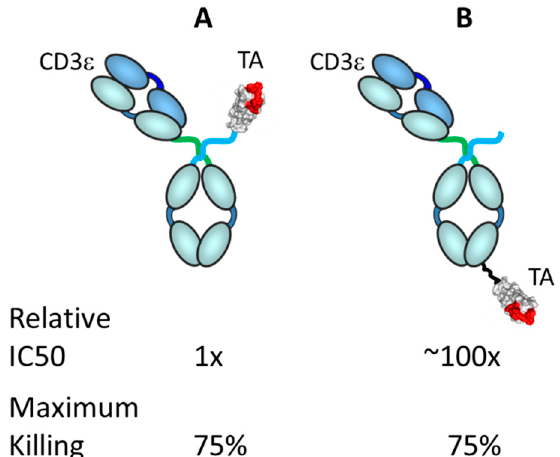
Figure 8. E ff ect of geometry on in vitro activity of an example TRBA. Cartoon of two antibody-centyrin fusions targeting CD3 ε with the Fab arm and a solid tumor antigen with the centyrin (~12 kDa engineered FN3 domain). ( A ). Centyrin fused to the hinge, making it close to the anti-CD3 Fab arm; ( B ). Centyrin fused to the C-terminus of the heavy chain, making it distal from the Fab arm. All components, molecule sizes and in vitro killing assay conditions (E:T 5:1, 24 h assay) were identical. Thus, only the architecture and geometry of the two TRBAs are different, resulting in a ca. 100-fold difference in potency. This simple example demonstrates how important the geometry of the binding arms can be in the design of future TRBAs. Data presented were derived from experiments provided Steve Jacobs, Janssen R&D. These data were previously presented at PEGS Boston, April 2018 with permission.